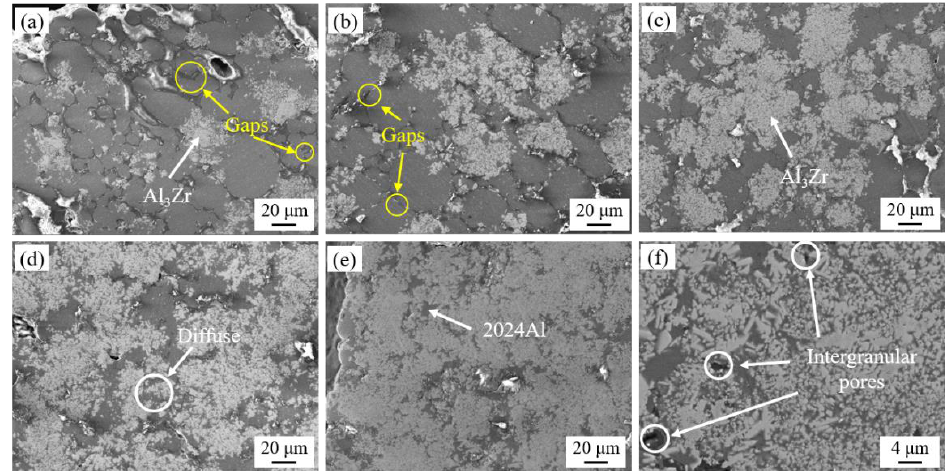
Figure 5. The SEM images of the composite pore wall were prepared with different Zr contents. ( a ) 5Zr; ( b ) 10Zr; ( c ) 15Zr; ( d ) 20Zr; ( e ) 25Zr; ( f ) 30Zr.